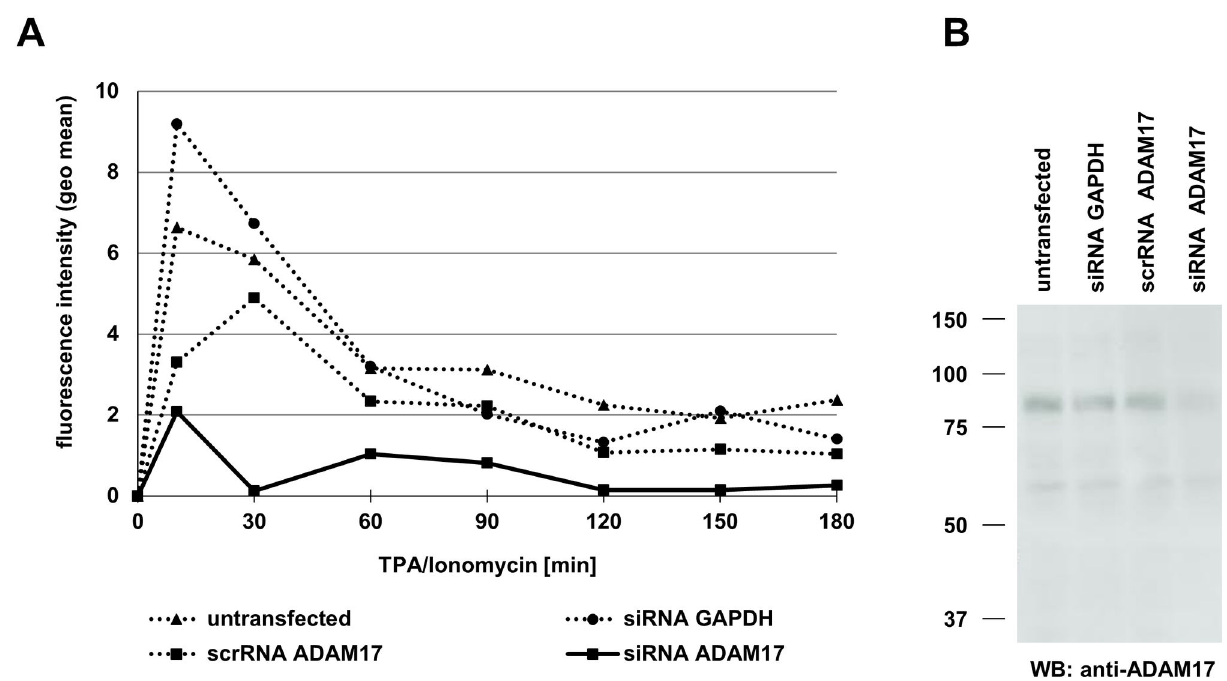
Figure 10. Knockdown of ADAM17 prevents inducible ADAM17 surface transition. A. PHA-activated T cell blasts were transfected or not with the indicated control or specific siRNAs. After 72 hours, the cells were stained for ADAM17 at the indicated time points after stimulation with TPA and Ionomycin. B. ADAM17 siRNA knockdown was verified at the protein level by Western blotting using mAb